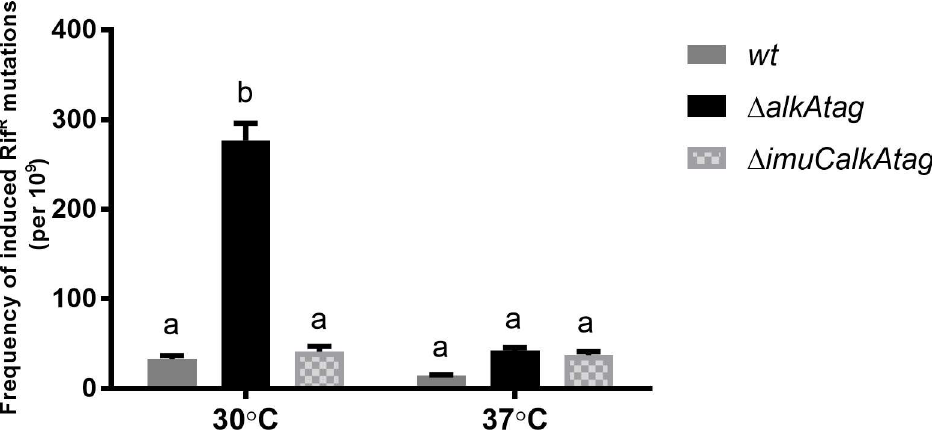
Fig 12. Effect of incubation temperature on the frequency of MMS-induced Rif R mutations in P . putida strains. P . putida wild-type( wt ), Δ alkAtag and Δ imuCalkAtag strains were incubatedwith 0.15 mM MMS overnight at 37˚C or 30˚C. The frequencies of MMS-induced mutagenesis were measuredas describedin Materials and Methods. Data represents the mean ( ± SE) values. Groups that have no common letter are significantly different at P < 0.0001, accordingto ANOVA followedby Bonferroni’s multiplecomparisons